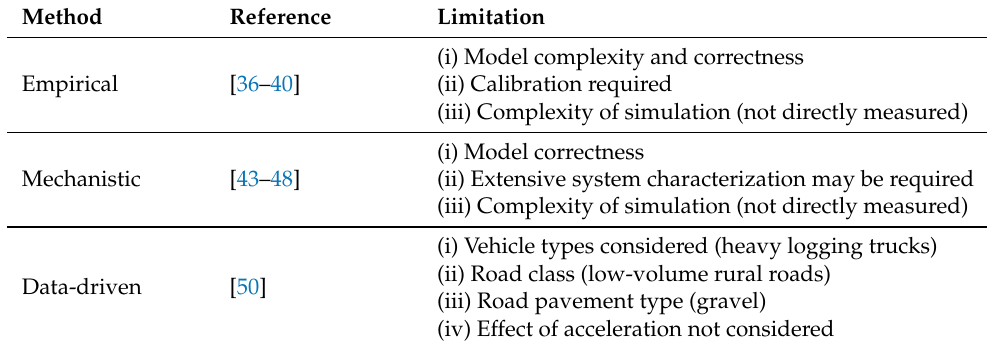
Table 1. Summary of related research